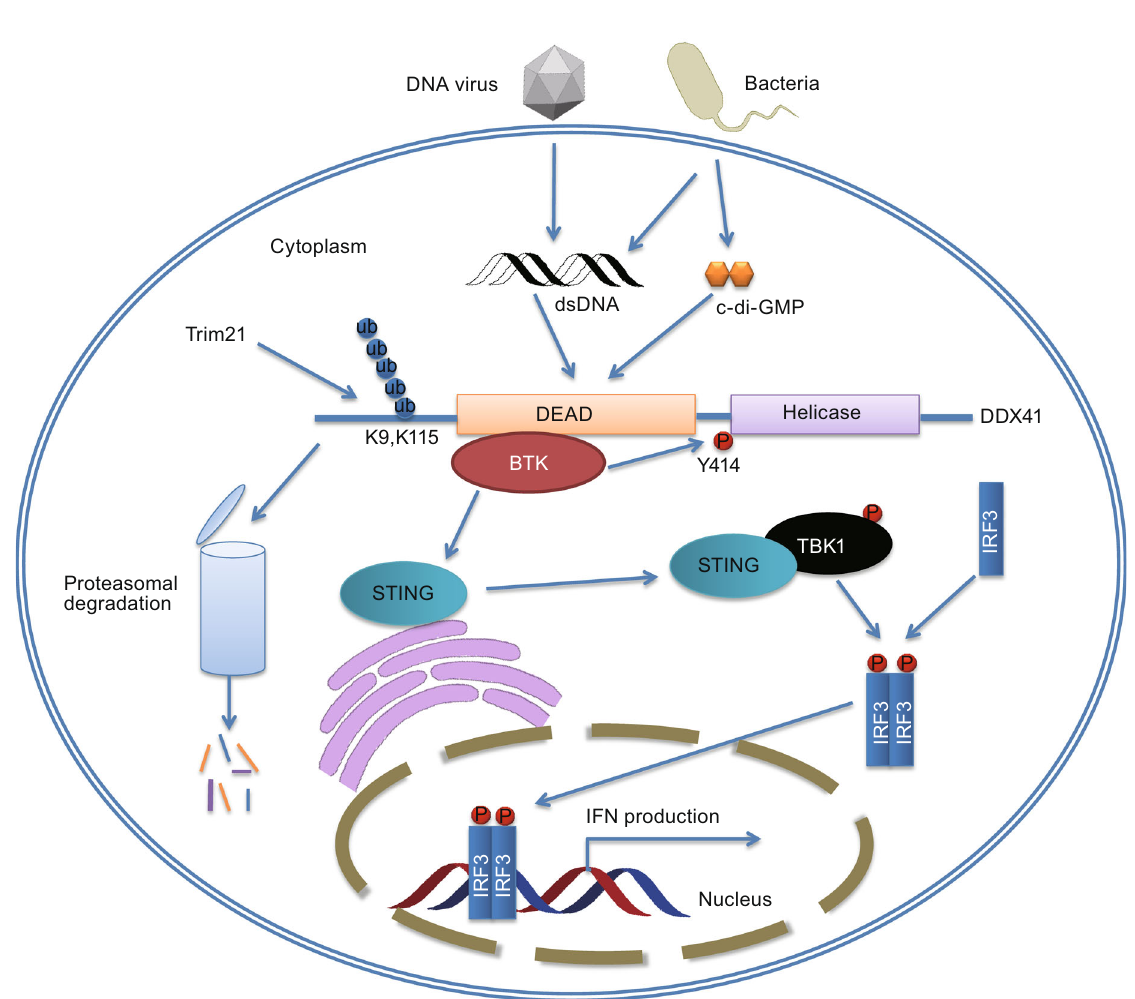
Figure 1. The signaling pathway of DDX41 in innate immunity. After infection, virus and bacteria release dsDNA or c-di-GMP to cells. DDX41 is then phosphorylated by BTK kinase at Y414 site and activated. The activated DDX41 can detect foreign PAMPs with DEAD domain, and then activate STING. Activated STING translocates from the endoplasmic reticulum (ER) to Golgi apparatus and interacts with TBK1 (Ouyang et al., 2012). The STING-TBK1 complex is required for the activation of TBK1 and the subsequent phosphorylation and nuclear translocation of IRF3, ultimately leading to expression of type I interferons. After immune response, DDX41 is ubiquitinated by Trim 21 at Lys9 and Lys115 sites, leading to degradation